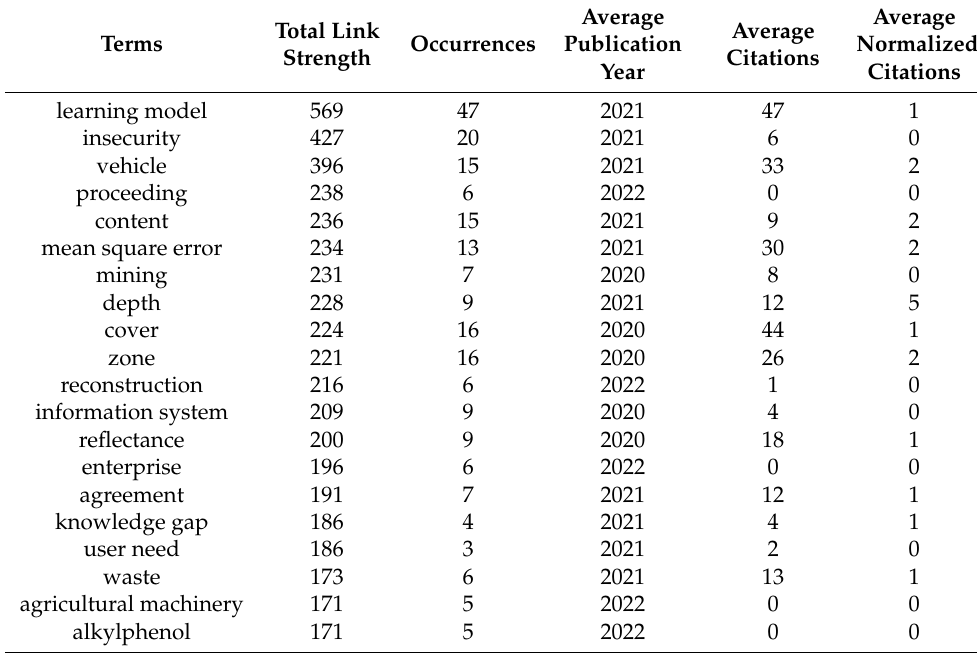
Table 1. Top 20 terms with the highest total link strength for text data, considering binary counting and 1 as the minimum number of occurrences of a